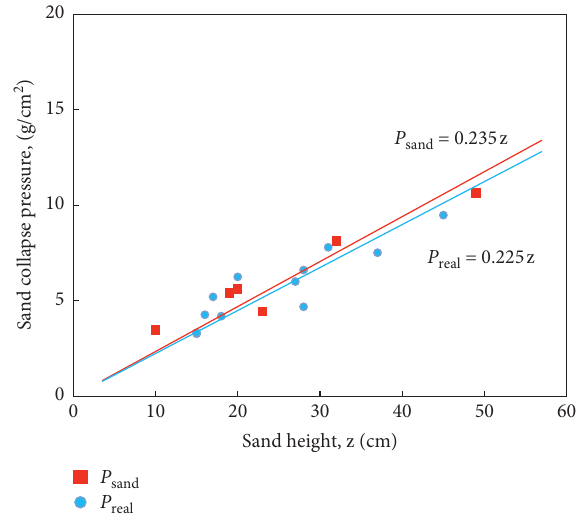
Figure 8: Comparison of the sand collapse pressure obtained by the preliminary sand and actual casting experiments. P sand : mea- sured pressure from preliminary sand experiment; P real : measured pressure from realistic